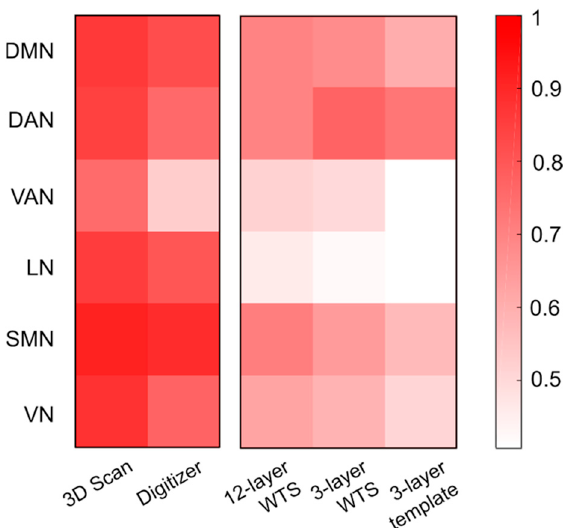
Figure 8. Impact of head modeling on the intra- and inter-network connectivity differences, for each RSN. This was assessed by calculating the correlation with values obtained using the reference analysis workflow. Two electrode localization techniques ( 3D Scan and Digitizer —on the left ) and three head tissue segmentation methods ( 12-layer WTS , 3-layer WTS and 3-layer template —on the right ) were tested.